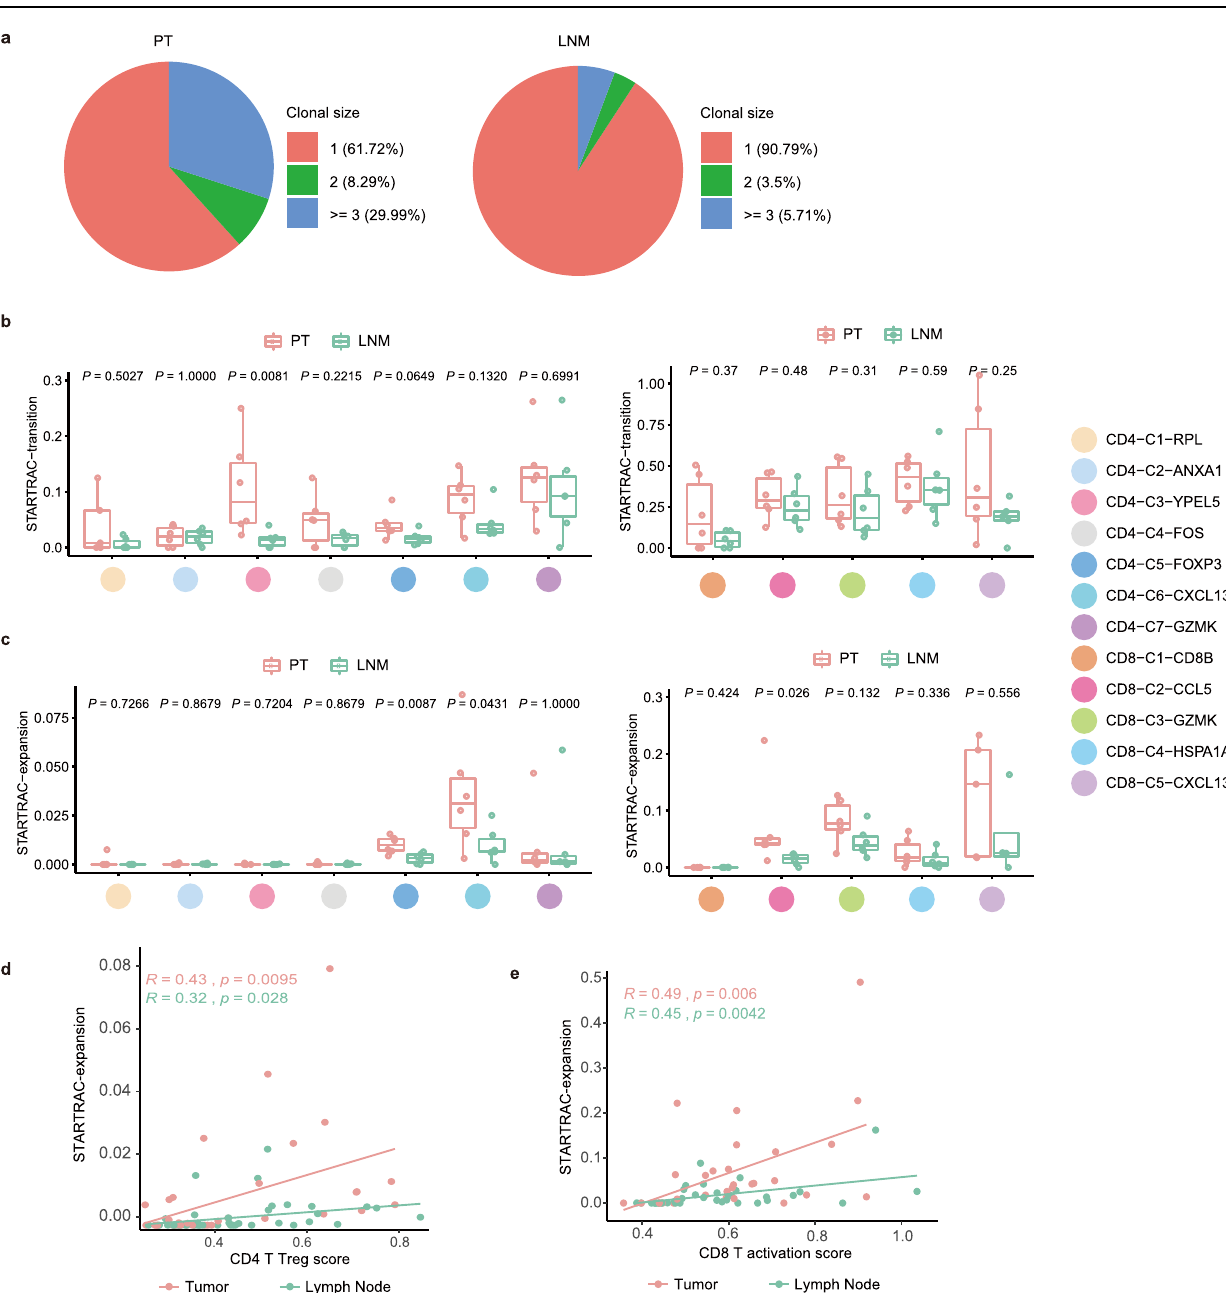
tissue.Two-sidedWilcoxontest.Intheboxplots,thecenterlinecorrespondstothe median, box corresponds to the interquartile range (IQR), and whiskers 1.5×IQR. d , e Scatterplot showing thecorrelation of Tregs score(d)orCD8activationscore ( x -axis) ( e ) with STARTRAC-expansion ( y -axis) on CD4 T clusters ( d ) or CD8 T cell cluster ( e ) across different tissues. Tregs score and CD8 activation score were calculated with the average expression of corresponding gene list (Supplement data 3). Each dot represents a corresponding cluster for each patient. Pearson correlation coef fi cient and linear regression were used. Source data are provided as a Source Data fi